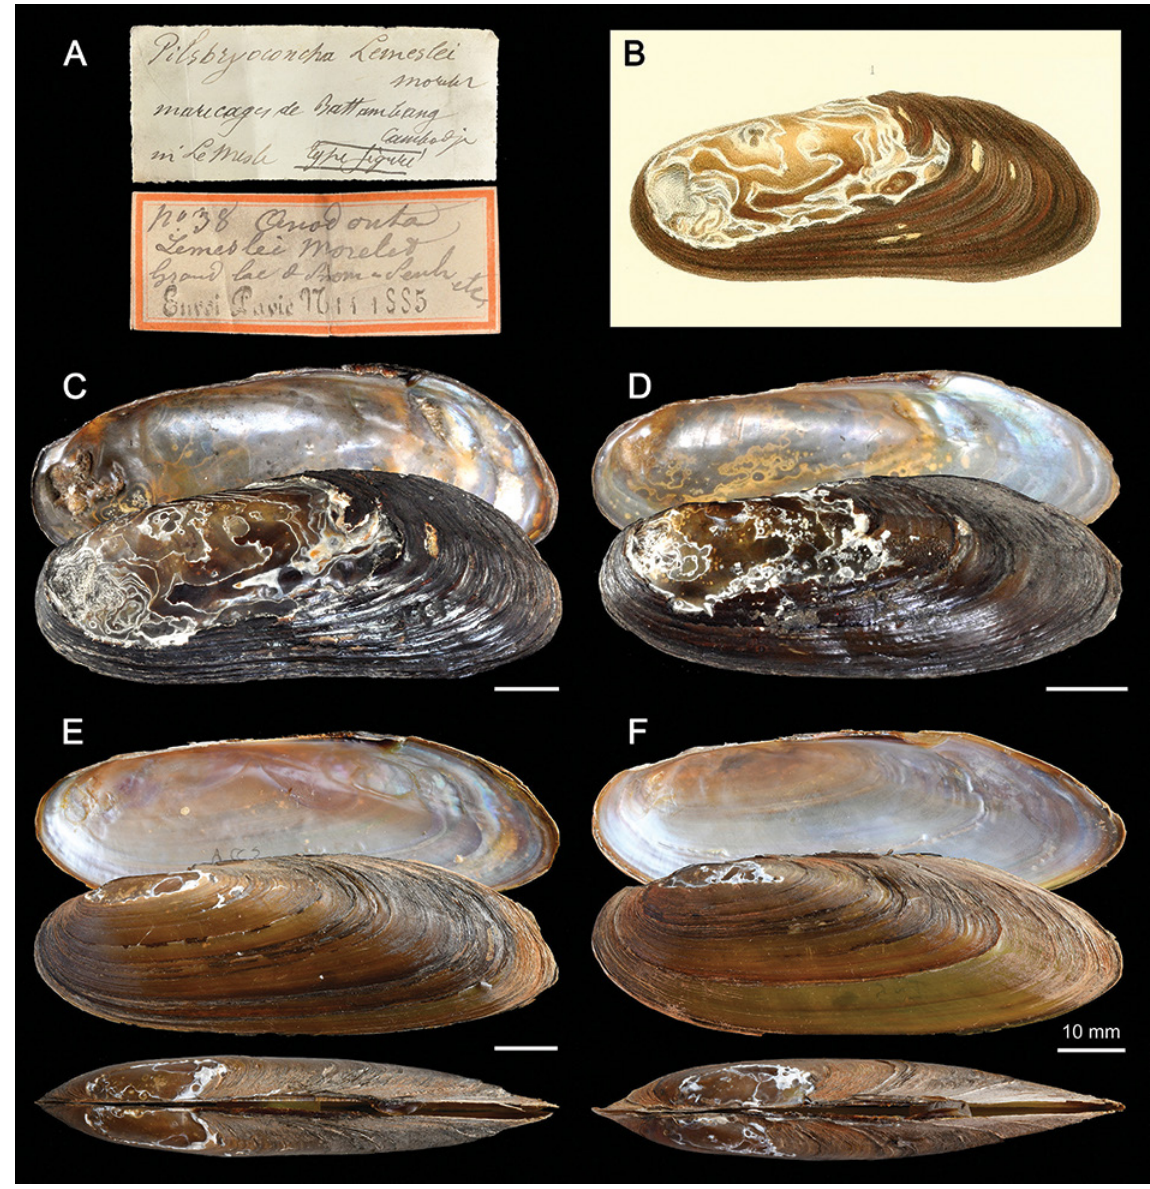
Fig. 5. Namkongnaia lemeslei gen. et comb. nov. A . Labels associated with the syntype lot. B . Original figure (after Morelet 1875: pl. 14 fig. 1). C–D . Syntype MNHN MP 3150 (photographs by V. Heros and M. Caballer) from Battambang Province, Cambodia. E . Specimen MUMNH-UNI2669. F .